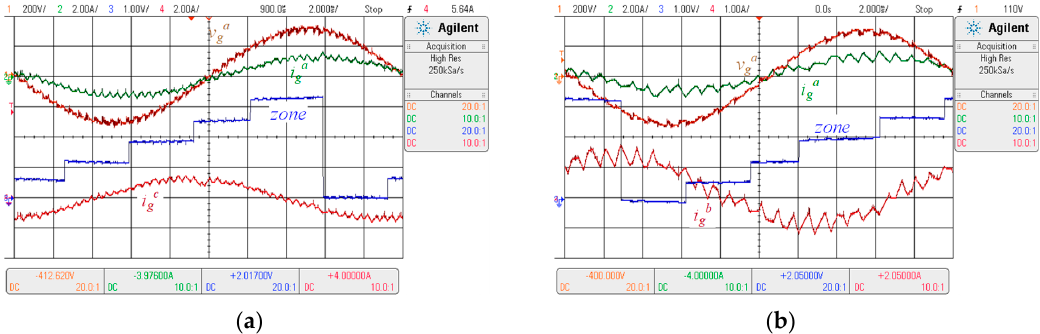
Figure 10. One period waveform ( a ) N = 48, i.e., f s = 2.4 kHz, ( b ) N = 24, i.e., f s = 1.2 kHz.